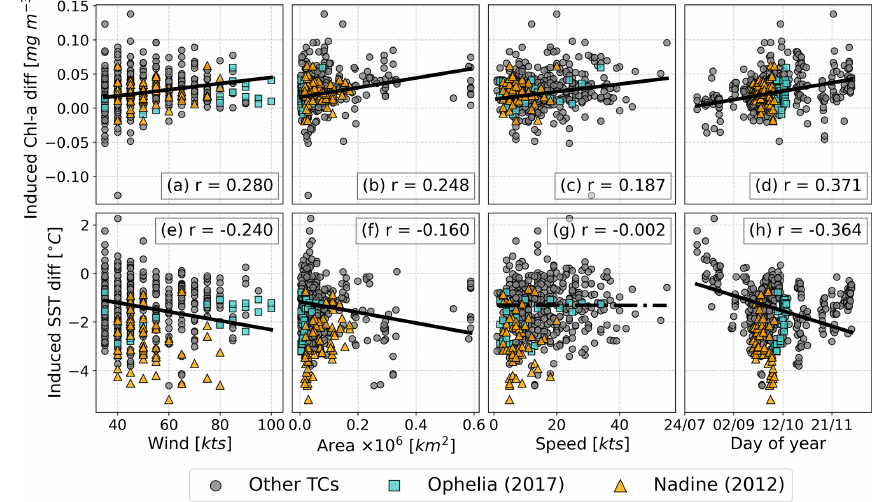
Figure 5. Same as in Fig. 4 but considering individual 6h observations. Two columns are added: (b) and (f) with respect to the area affected by that observation and (d) and (h) with respect to the time of the year when that observation occurred.